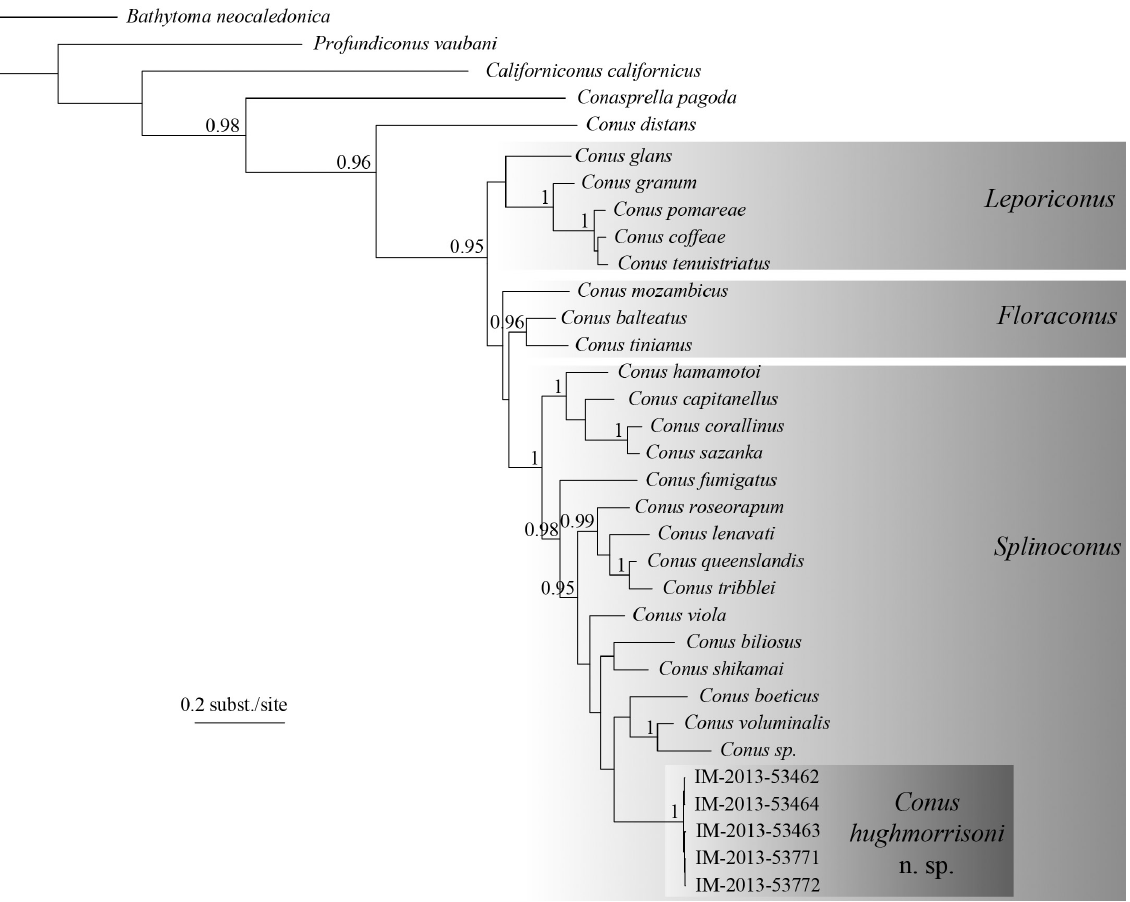
Fig. 1. Bayesian phylogenetic tree obtained with the COI gene. Posterior Probabilities (> 0.9) are shown above